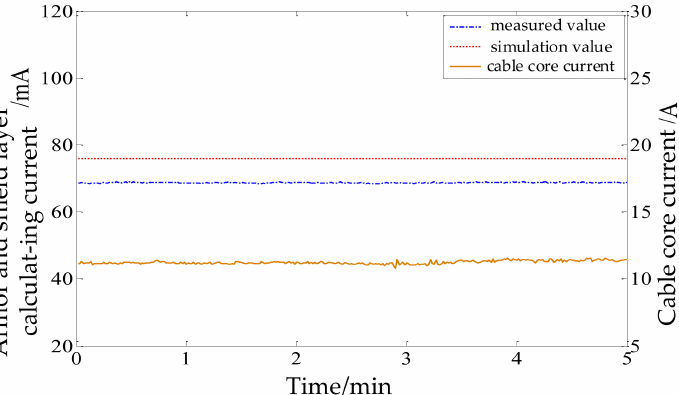
Figure 17. Comparison of simulated circulating current and actual measured value for 11.4 A model of wire core